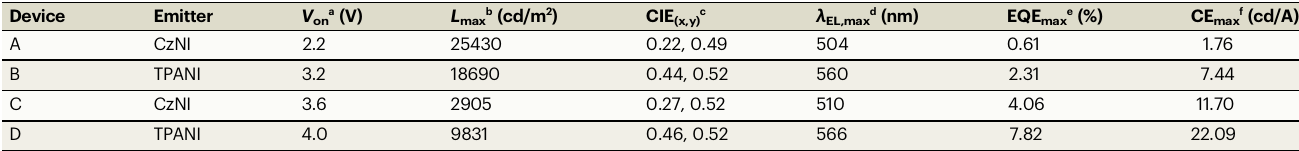
Table 2 | Summary of EL performance of the CzNI- and TPANI-based non-doped OLEDs Device